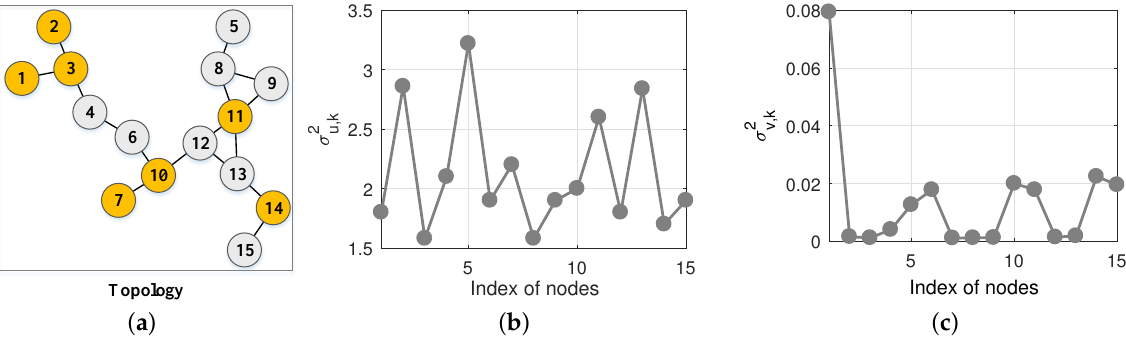
Figure 6. The topology, regressor power and noise profile: ( a ) network topology; ( b ) regressor power; ( c ) noise profile.